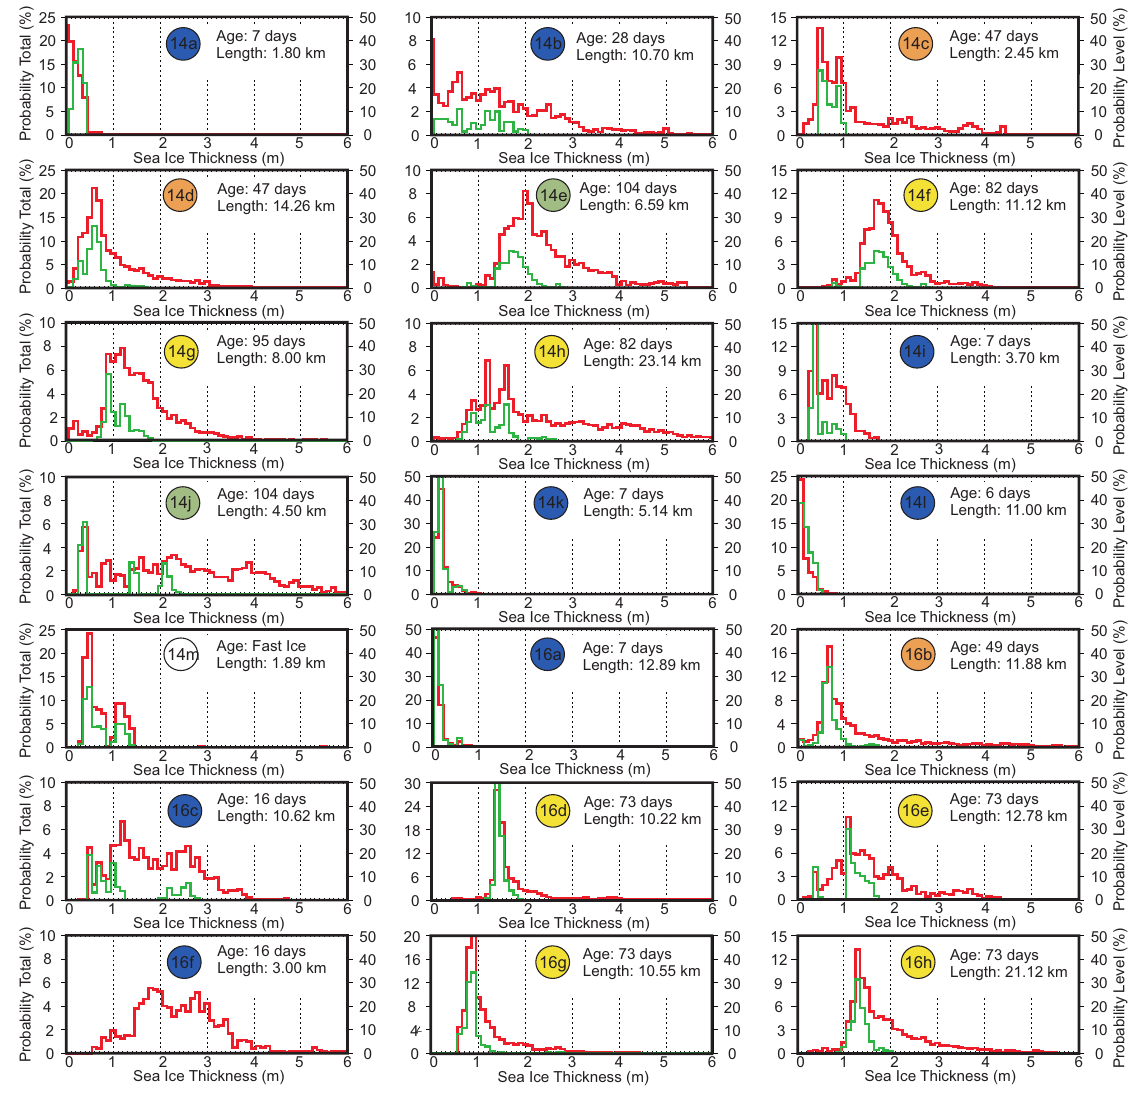
Fig. 7. Sea-ice thickness histograms of profiles shown in Figs. 5 and 6. Red histogram and axis on the left side of each diagram are for all ice thicknesses, whereas green histogram and axis on the right side of each diagram are for level ice only. No level ice was present in section 16f. Lengths of profiles and ages of the ice are shown in each diagram. Circle colors refer to the polynya events in which the respective sea-ice profiles originated (for color code, see Table 1).